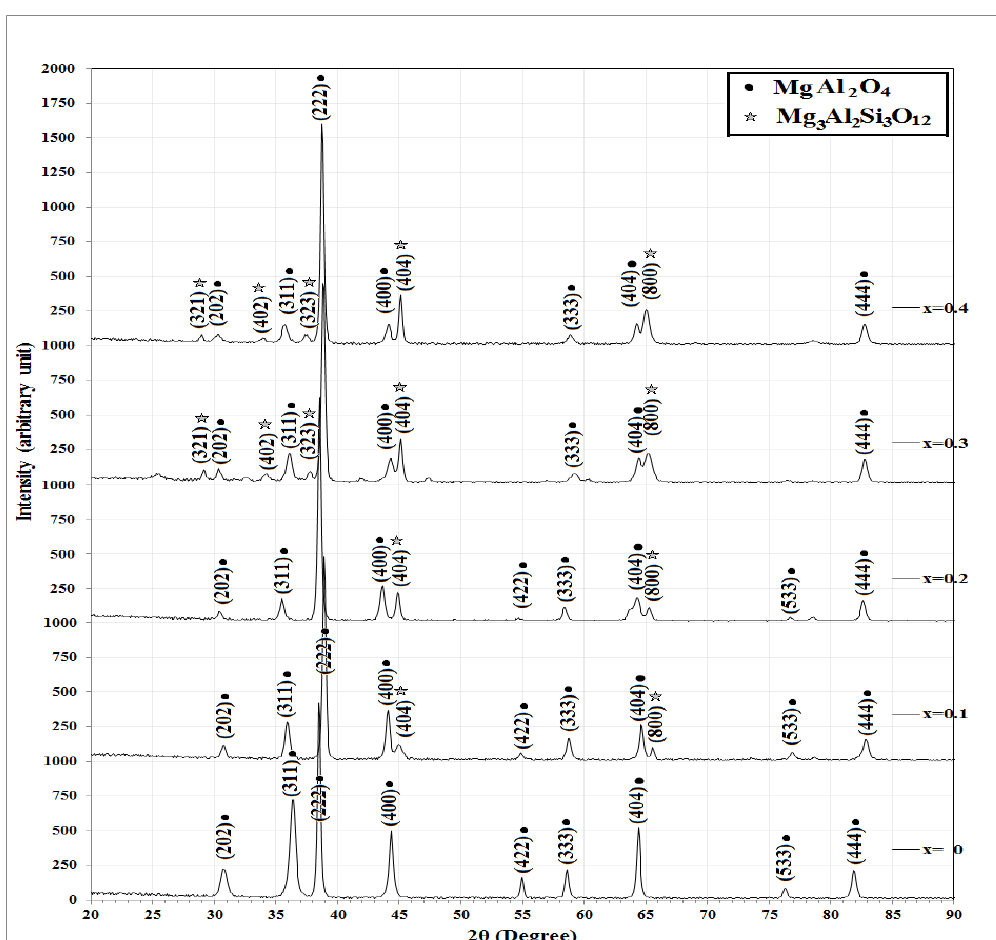
Fig.1: XRD patterns of (Mg